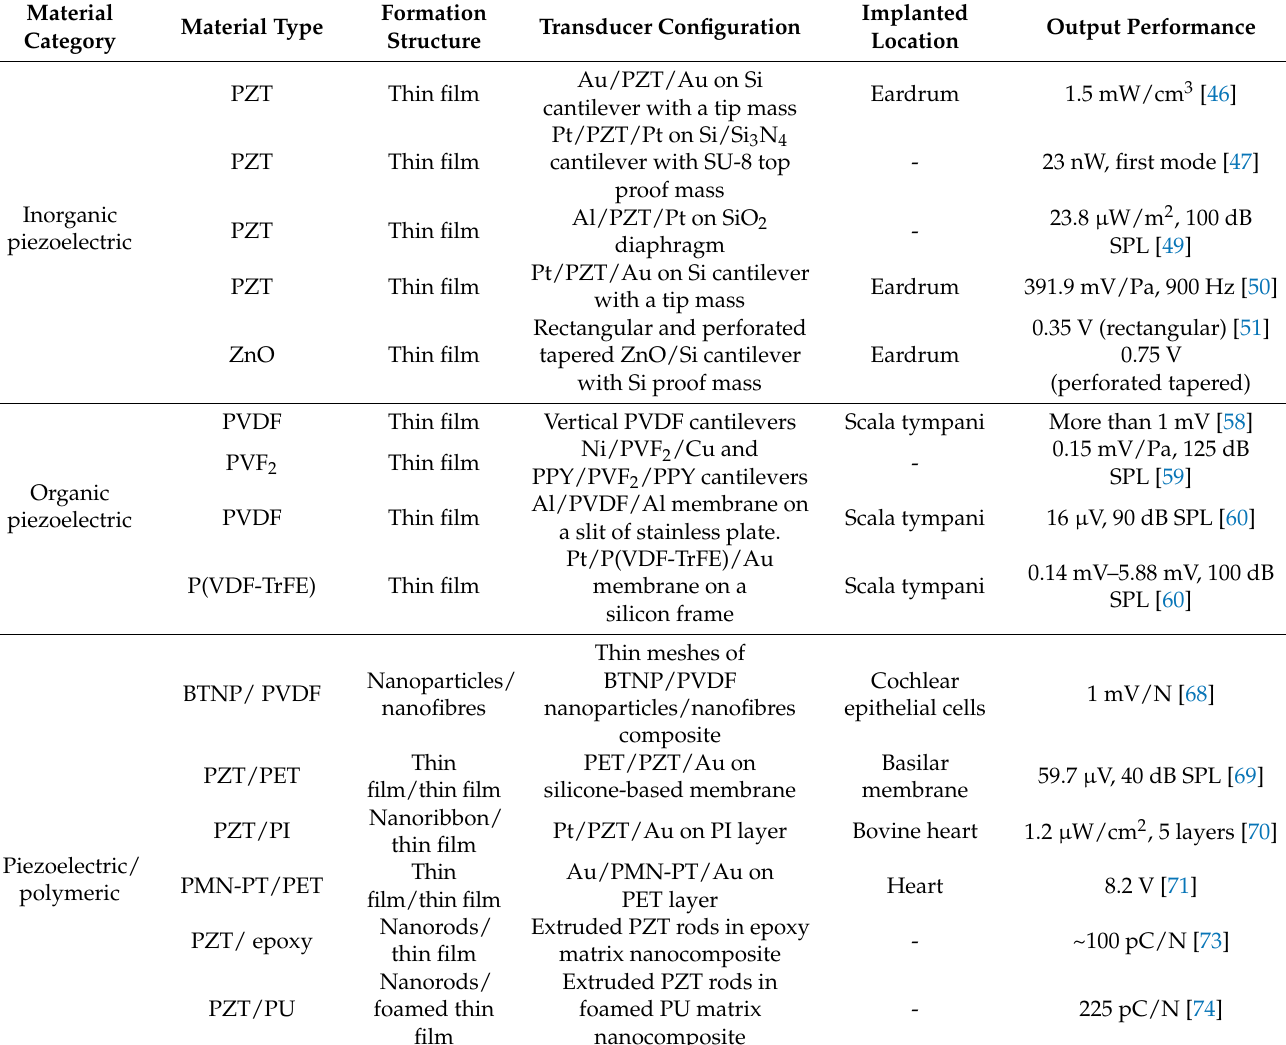
Table 3. Summary of piezoelectric material, potentially used for energy harvester in cochlear device application.